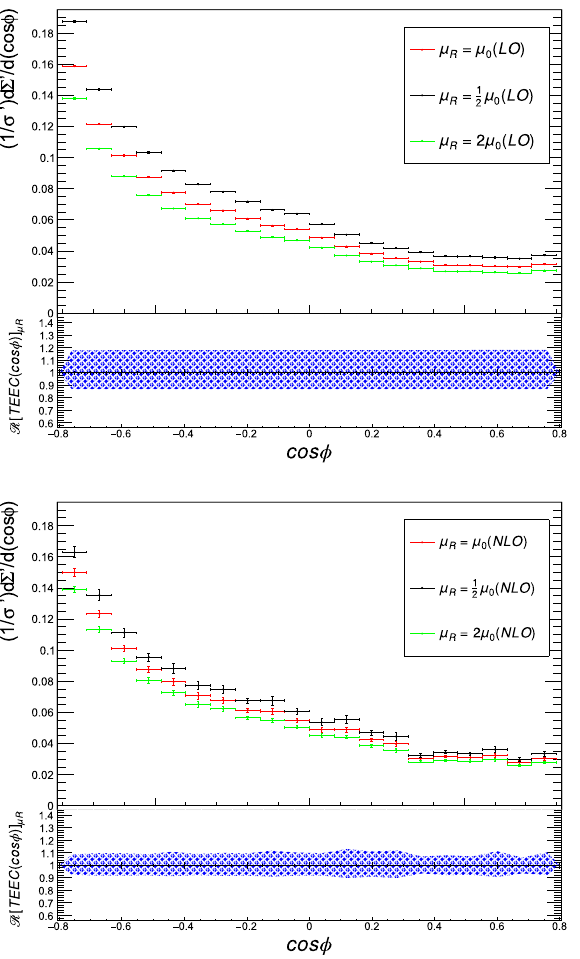
inal scale defined in the text, calculated with the MMHT14 PDFs for the low- Q 2 : 5 . 5GeV 2 < Q 2 < 80GeV 2 at HERA. The correspond- ing μ R -dependence is also shown in terms of R [ TEEC ( cos φ) ] μ and R R [ ATEEC ( cos φ) ] μ , defined in Eq. R